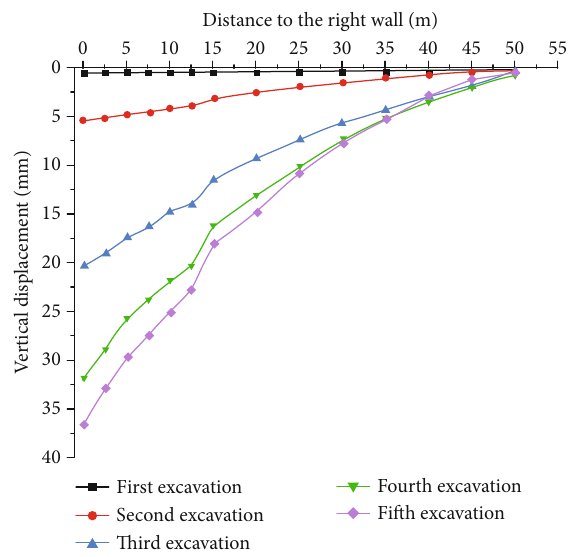
Figure 6: Vertical displacement of the ground surface on one side of each excavation stage.